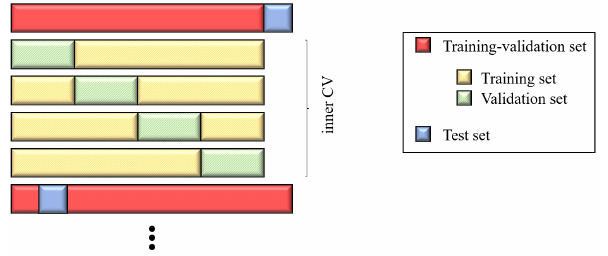
Figure 4. Scheme of the outer 10-fold CV and the inner 4-fold CV applied for the GBM